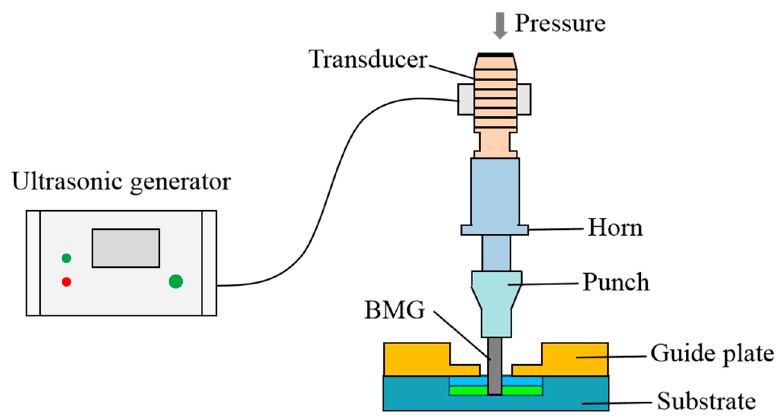
Figure 1. Ultrasonic vibration ‐ assisted elastic deformation diagram.